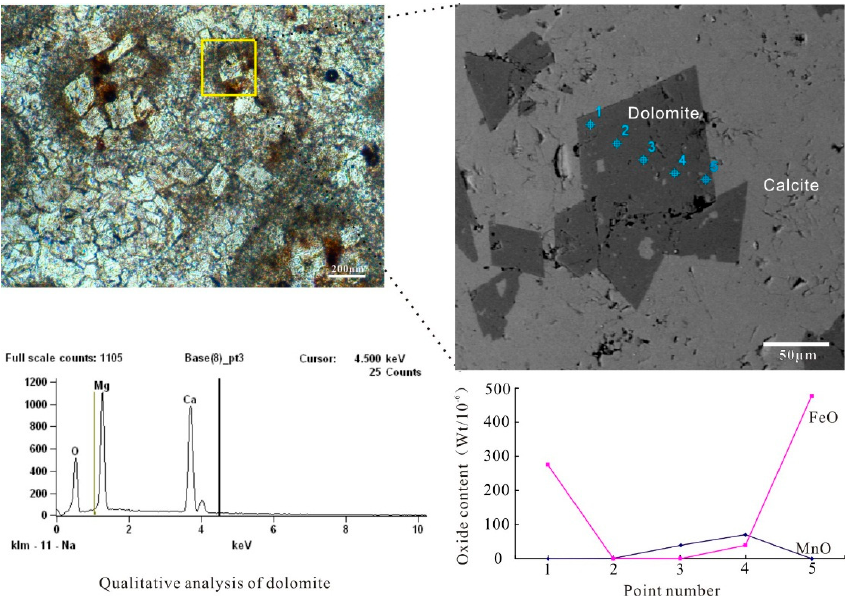
Figure 7. Fe and Mn oxide composition curve of CCCR dolomites (sample YA-74-2).